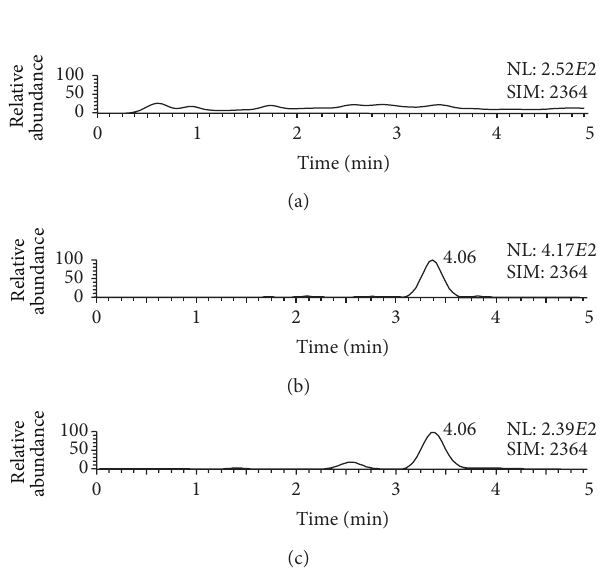
𝛼 -La. Its application might be helpful to pharmaceutical enterprise on new drug